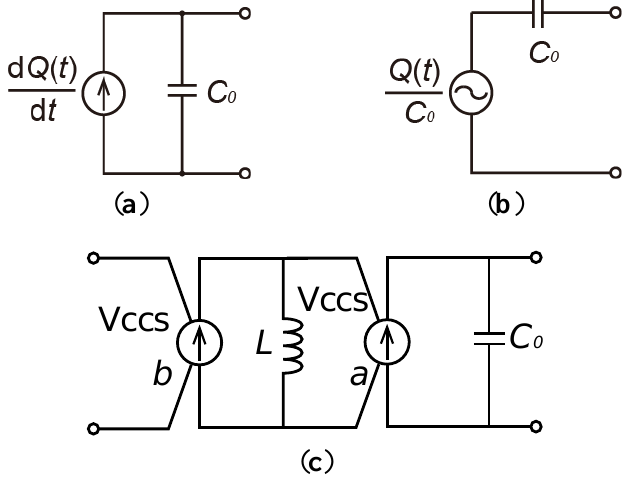
Figure 3. Circuit models for a charge source with a piezoelectric capacitor. ( a ) Current-source model; ( b ) Voltage-source model; ( c ) Vccs